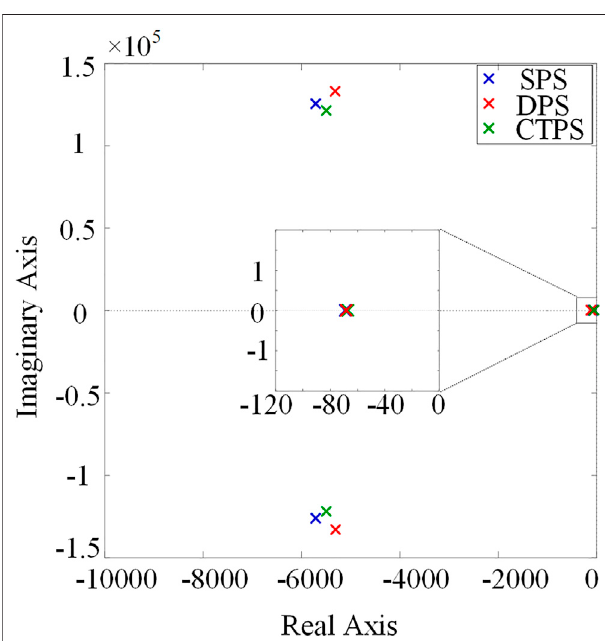
FIGURE 5 | Poles of the closed-loop current control transfer